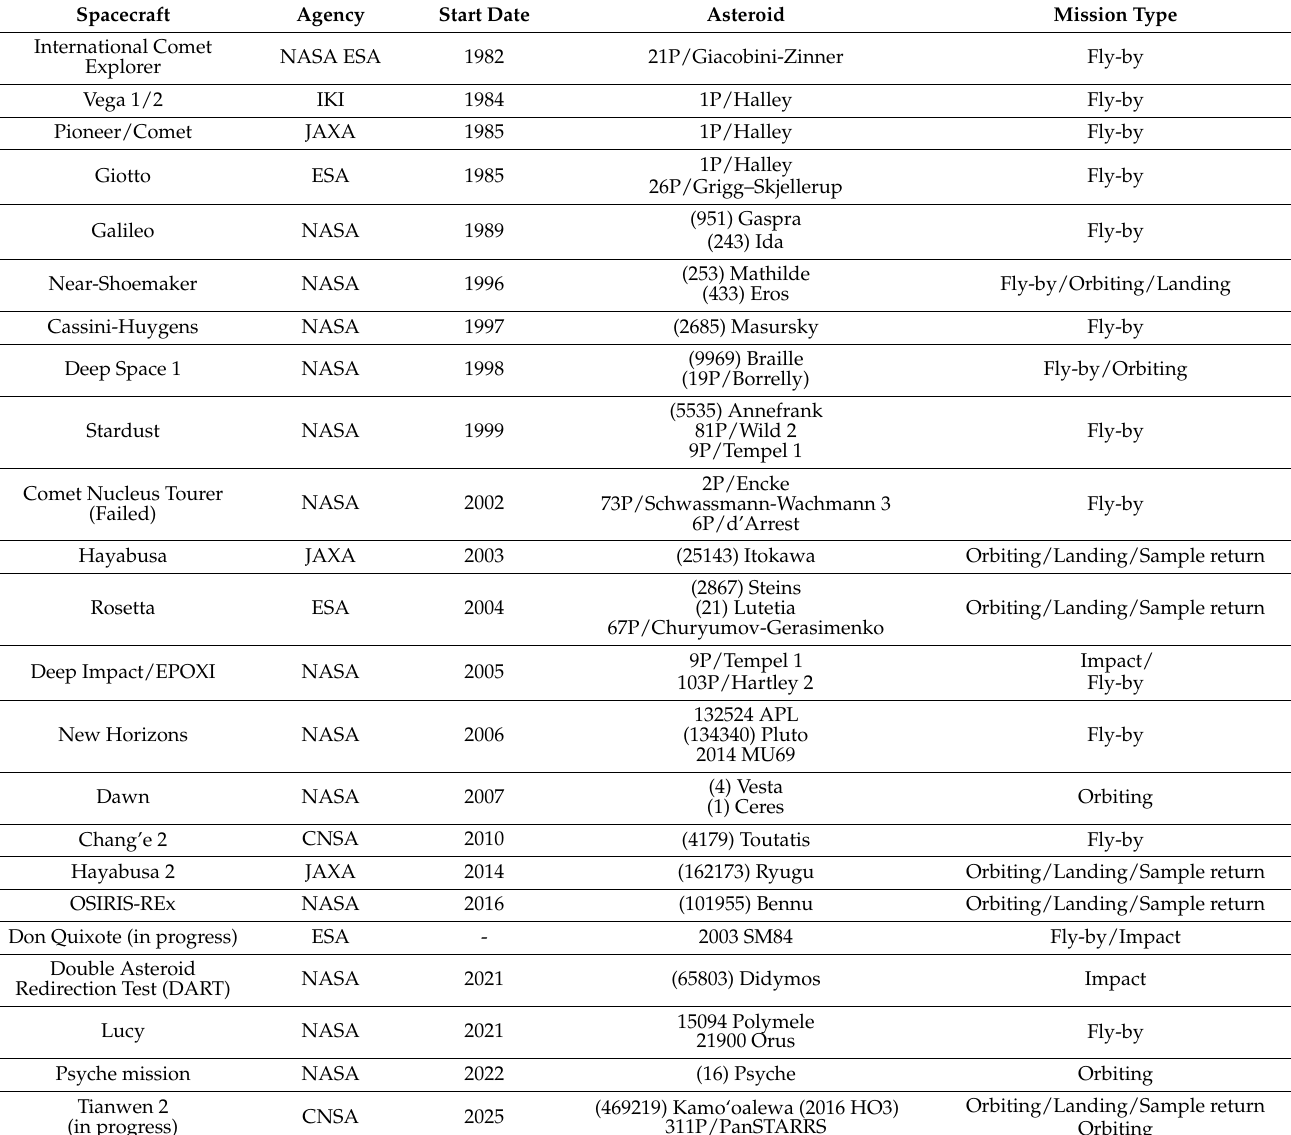
Table 3. Asteroid exploration